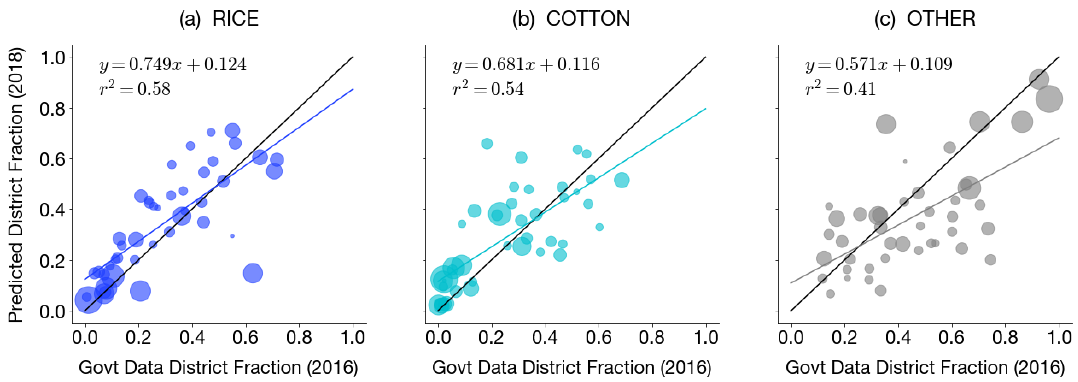
Figure 9. Comparison of model predictions ( y axis) to government statistics ( x axis). Results are shown for ( a ) rice, ( b ) cotton, and ( c ) other crops of the 2018–2019 kharif season. Predictions and r 2 values are based on a random sample of cropland from the GFSAD product [72] on which Sentinel-1 and -2 features were extracted and run through the 1D CNN. The black line shows the y = x line, while the blue line shows the line of best fit. The coefficient of determination ( r 2 ) and equation of best fit line are provided. The size (area) of a point is proportional to the area of its corresponding district.